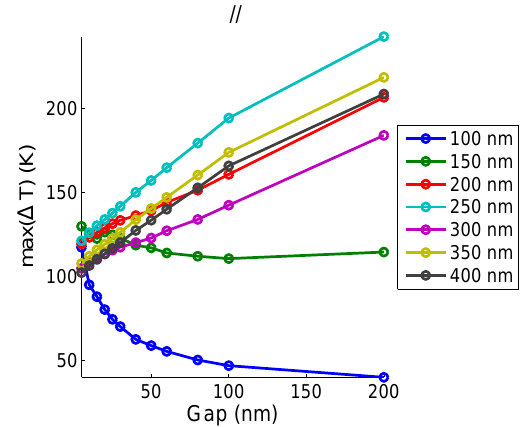
Figure 4: Photo-thermally induced dilations of the sur- face of each nanorod (the two nanorods are a dimer nanonatenna). L = 400 nm, R 1 = 30 nm and the gap is indicated.